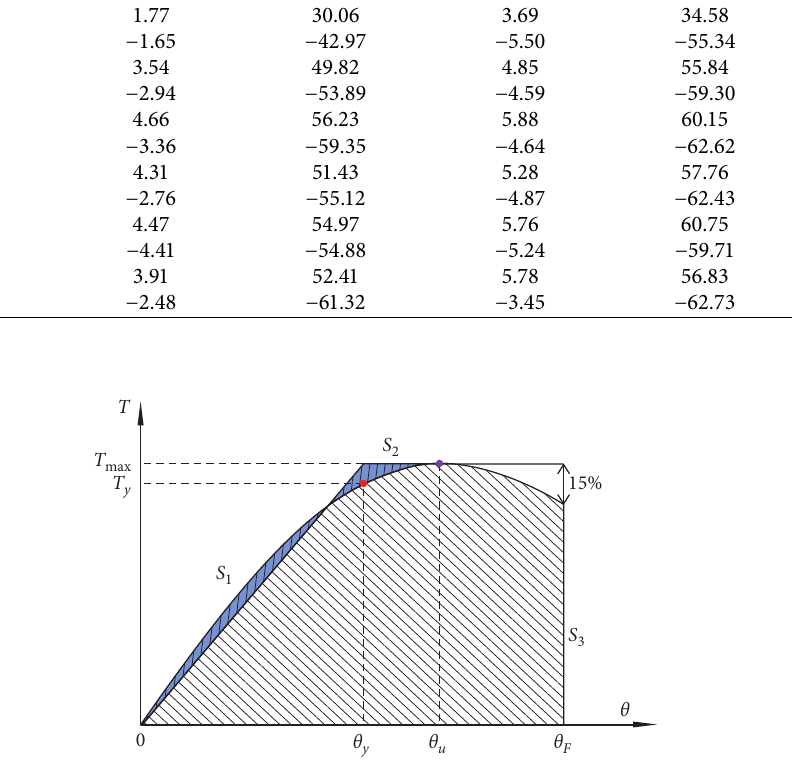
Figure 15: Equivalent elastic-plastic energy method ( S curve [42].